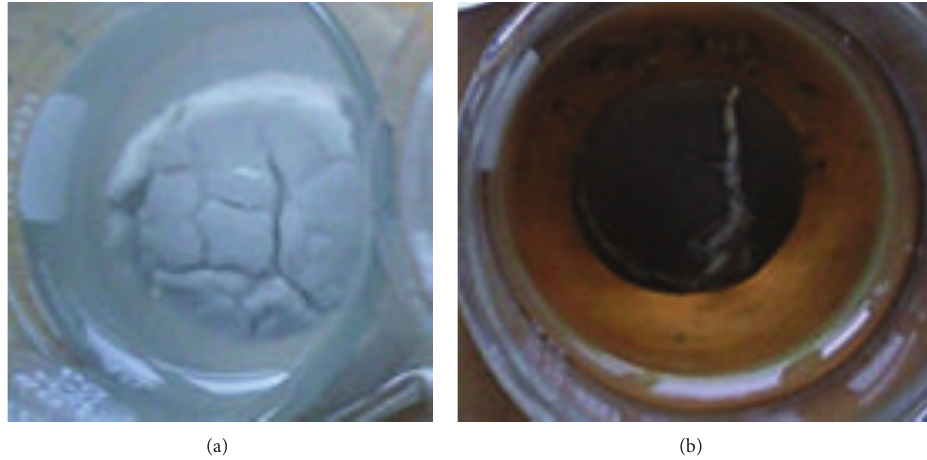
Figure 6: The status of mud balls immersed in water (a) solution and 2% BG (b) solution for 48 h.